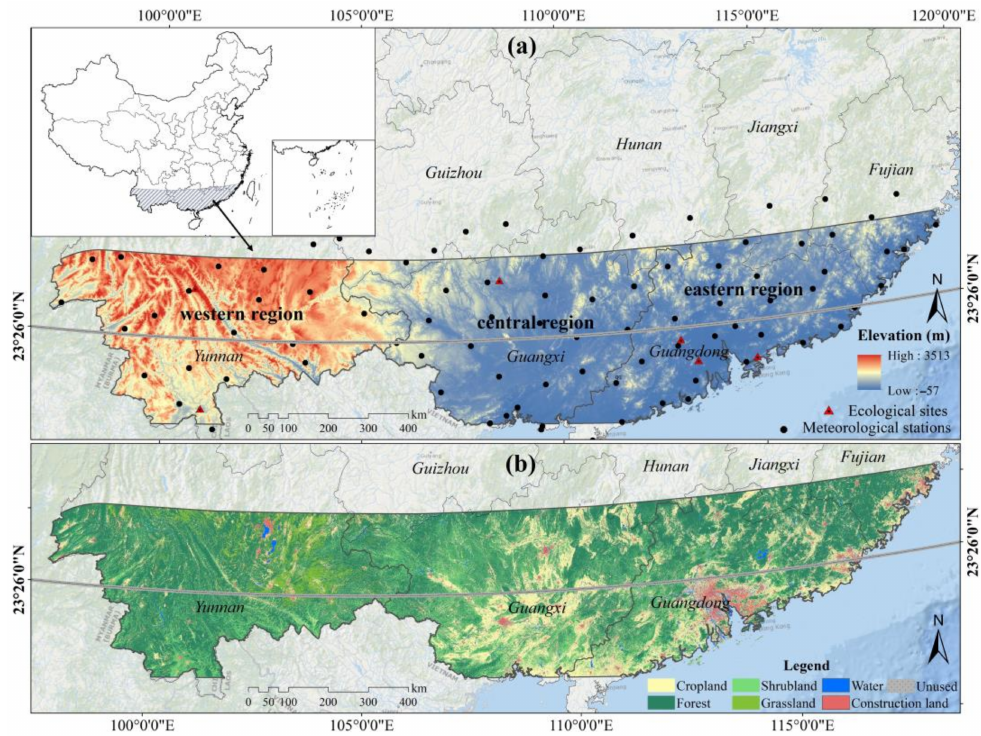
Figure 1. Location of the Tropic of Cancer transect. ( a ) Elevation, meteorological stations, and ecological sites, and ( b ) land cover in